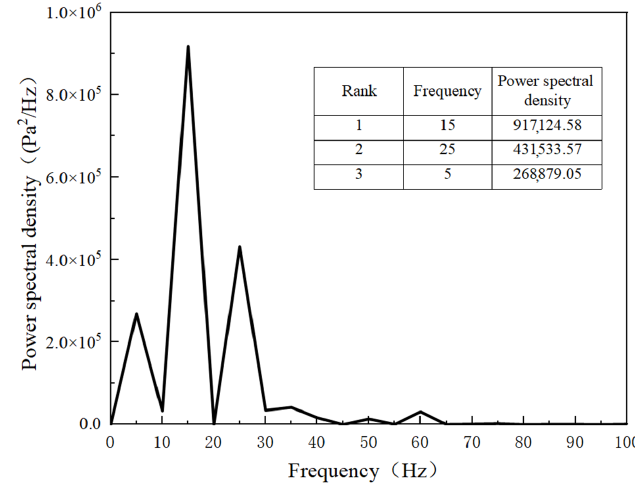
Figure 10. Main frequency distribution of the initial compressional wave. As shown in the diagram, there are three main frequencies of the initial compres- sional wave: 5, 15, and 25 Hz . Specifically, 15 Hz corresponds to the main frequency car- rying the highest energy. When the main frequency of the compressional wave is in the Helmholtz resonator band, resonance occurs. The resonance phenomenon consumes a large amount of energy and reduces the compressional wave gradient, thereby relieving the micro-pressure wave amplitude. According to Langfeldt [25] and Wang et al. [26], the